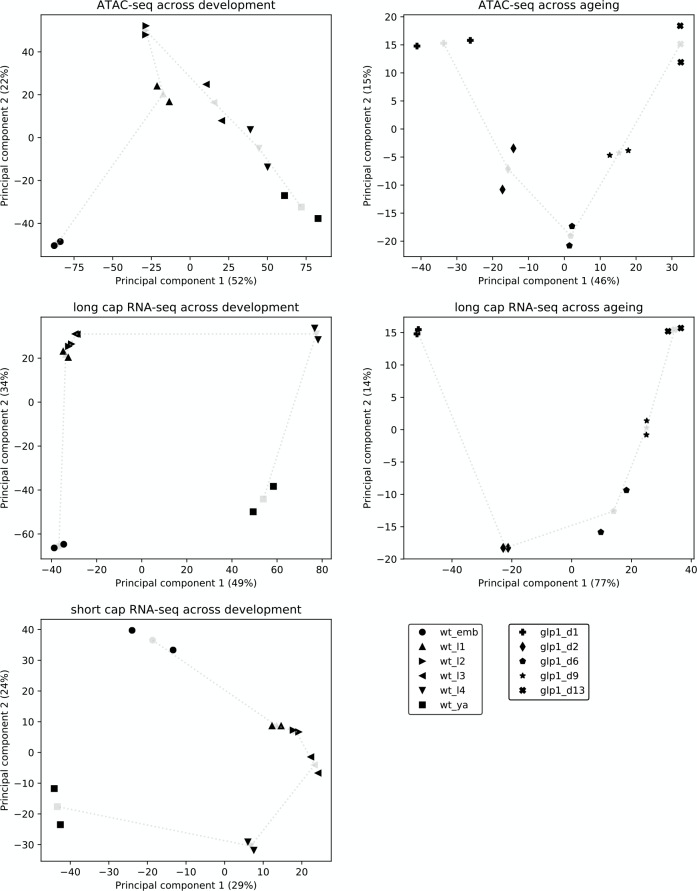
Reproducibility and broad relatedness of ATAC-seq and RNA-seq data.Reproducibility and broad relatedness of the different samples and time points in ATAC-seq (top), long cap RNA-seq (middle), and short cap RNA-seq (bottom). We applied PCA to peak accessibility at promoters (ATAC-seq), read counts at annotated genes (long cap RNA-seq), and 5' end read counts at promoters (short cap RNA-seq). Black markers show different biological samples (two per time point) whereas gray markers show centroids, calculated by averaging the two samples collected at the same time point. Gray dotted lines show the time progression across development or ageing.